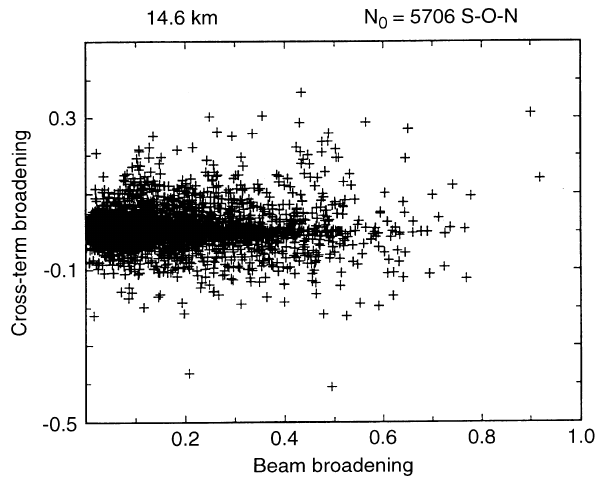
Fig. 9. Comparison of the cross-term (Term II of Eq. 16) with the beam-broadening term (Term I of Eq. 16) computed using the observed wind speeds and vertical wind shears at WSMR at 14 : 6km